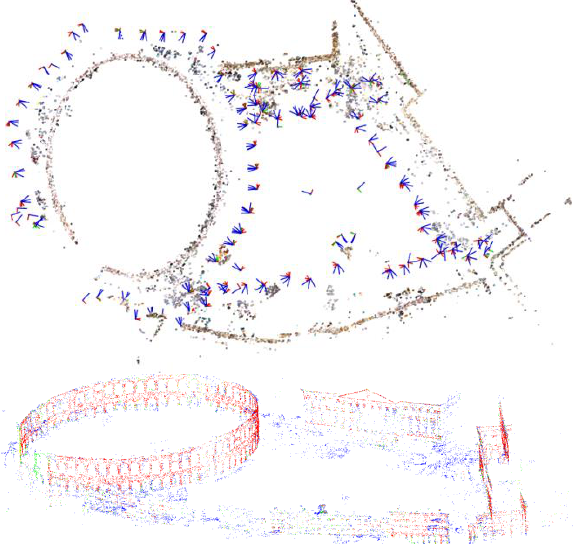
Figure 8. Result for the Piazza Bra dataset (Farenzena et al., 2009). The largest of five resulting models is displayed (287 of 329 images). Image connectivity cut offs and drop off in reconstruction quality occur in areas with weak observation redundancy, as indicated by the colors in the lower image (blue, green, yellow and red for 2, 3, 4 and ≥ 5 observations). However, narrow baselines are handled